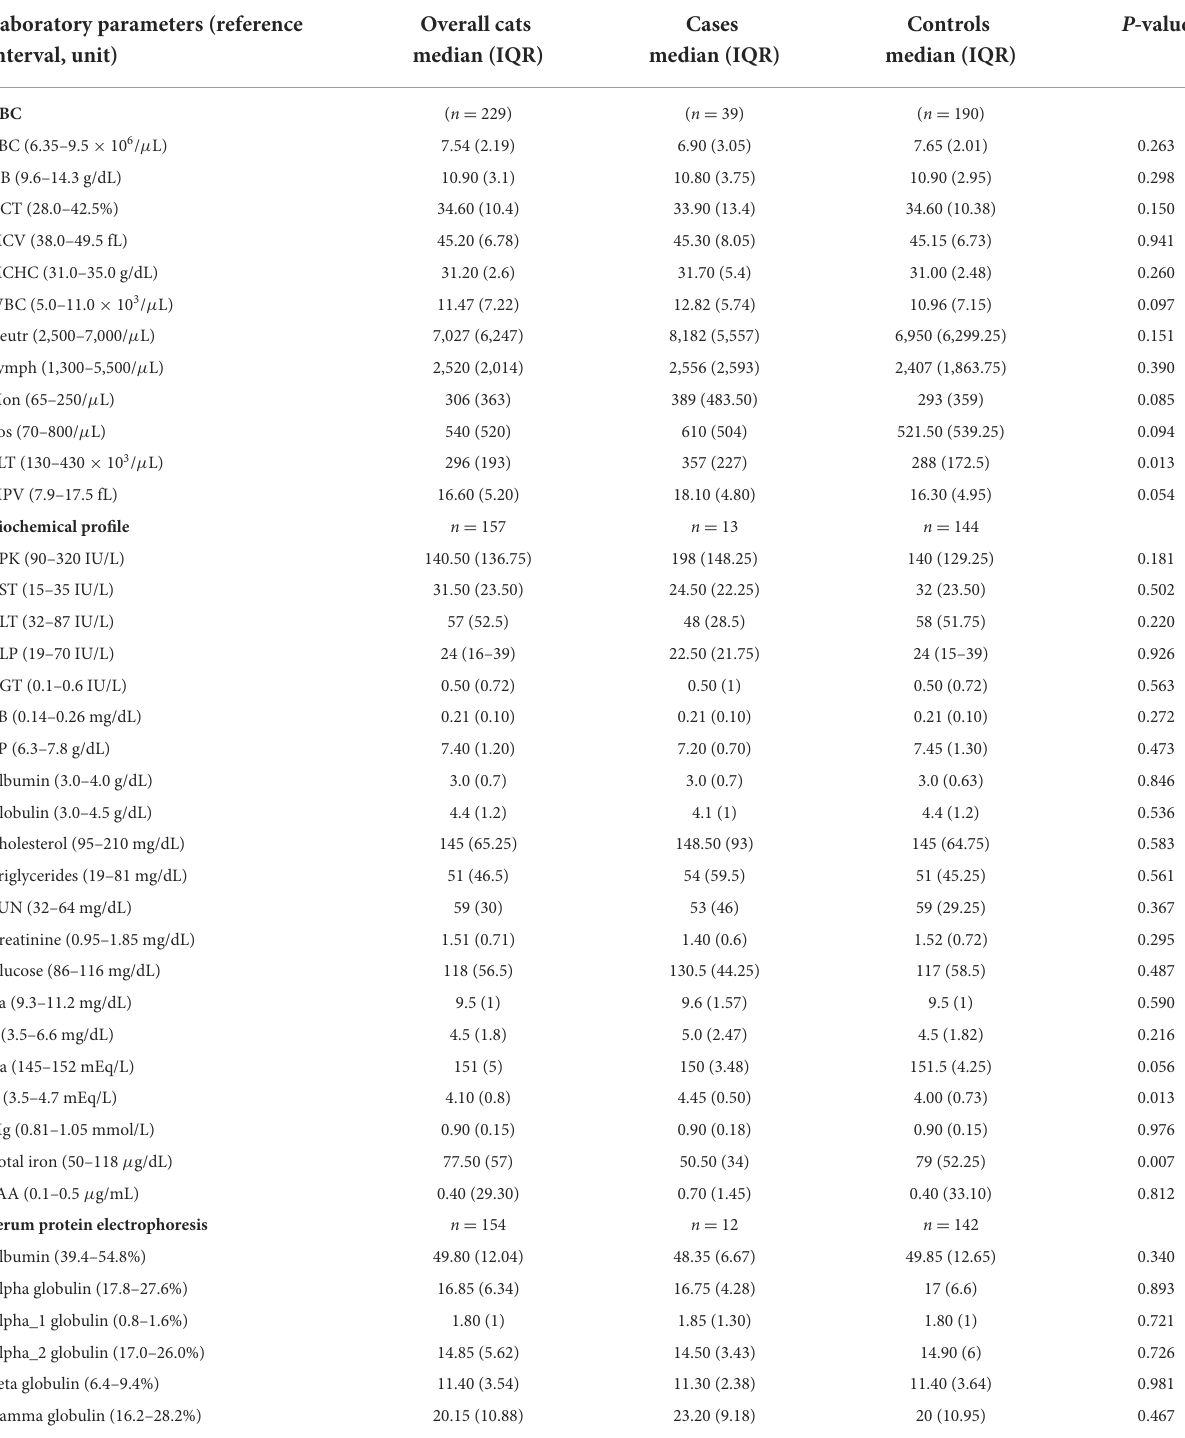
TABLE 2 Laboratory findings of all cats and infected and non-infected Cytauxzoon spp.